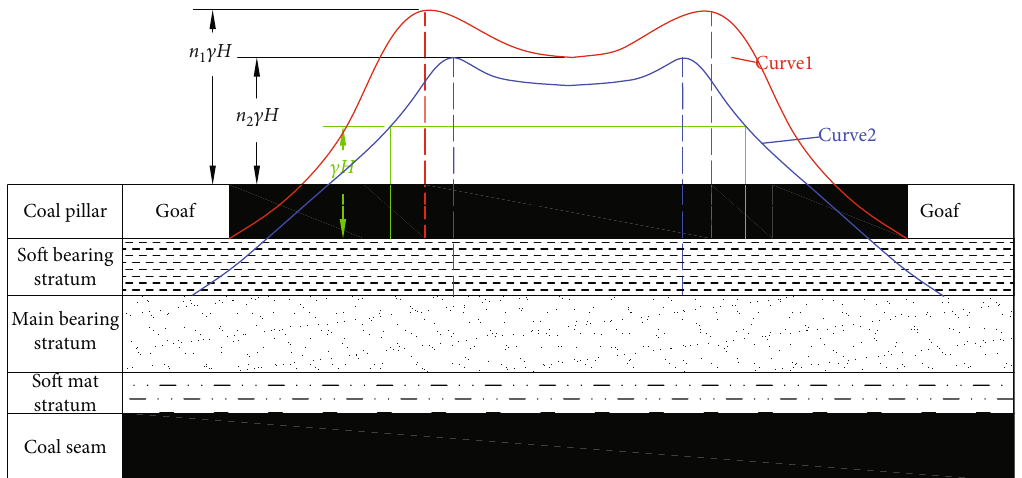
Figure 3: The layered coal pillar fl oor and their stress